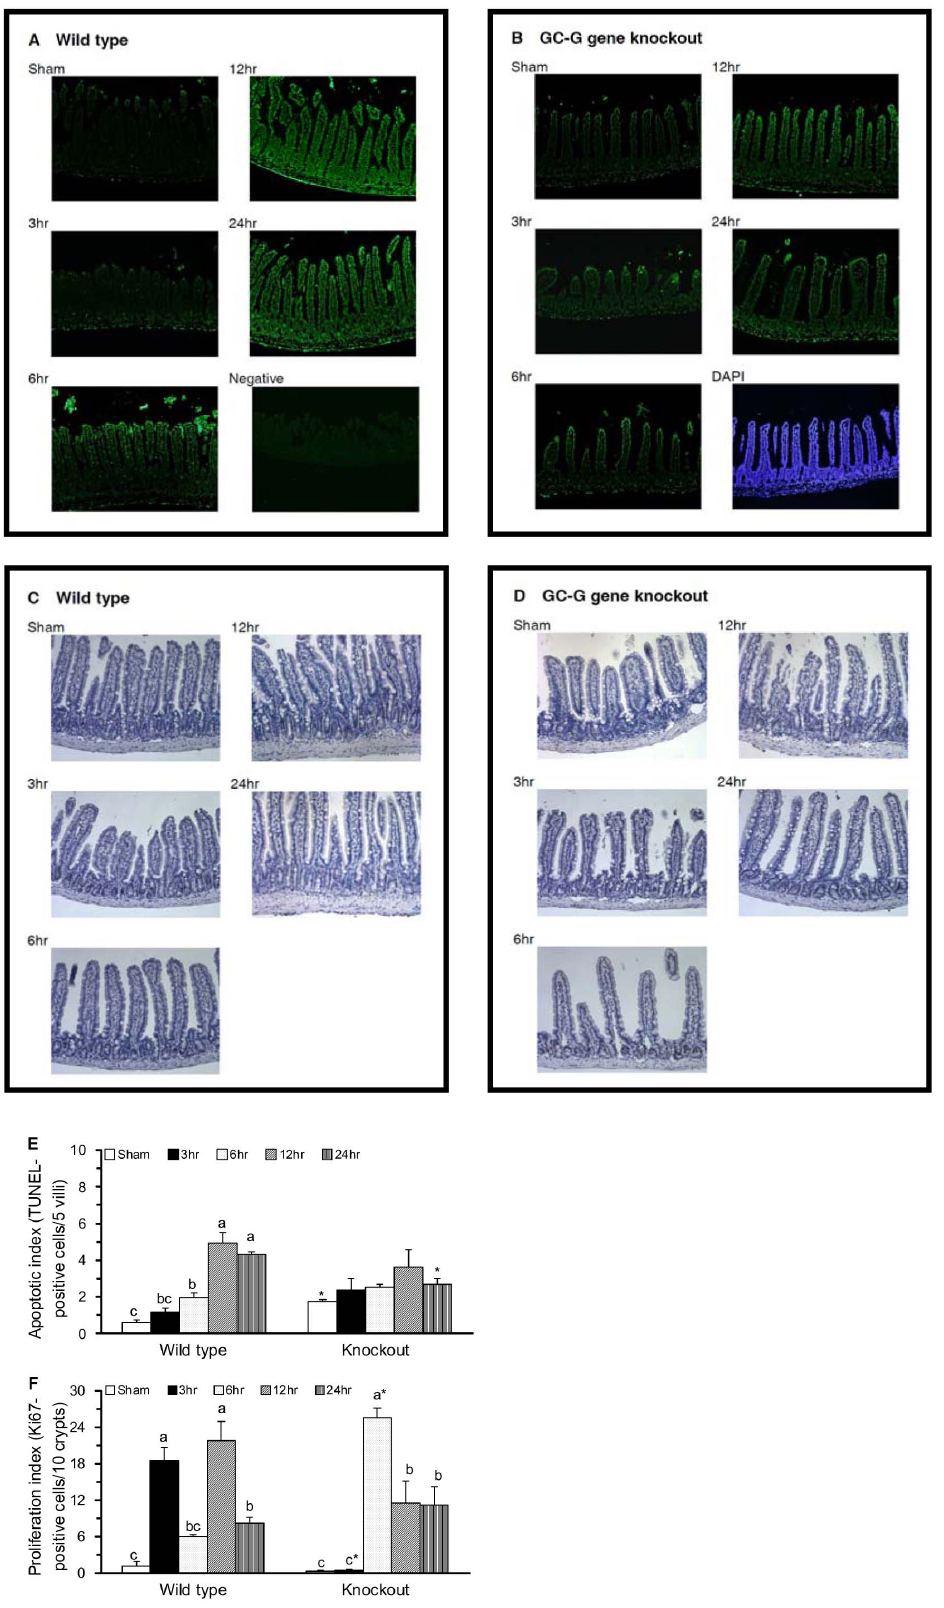
Figure 4. Immunofluorescence analysis of apoptotic cells and immunohistochemical analysis of cell proliferation in jejunal sections. In situ detection of apoptotic cells using TUNEL assay is shown with green fluorescein label in the jejunum of WT (A) and KO (B) mice. A